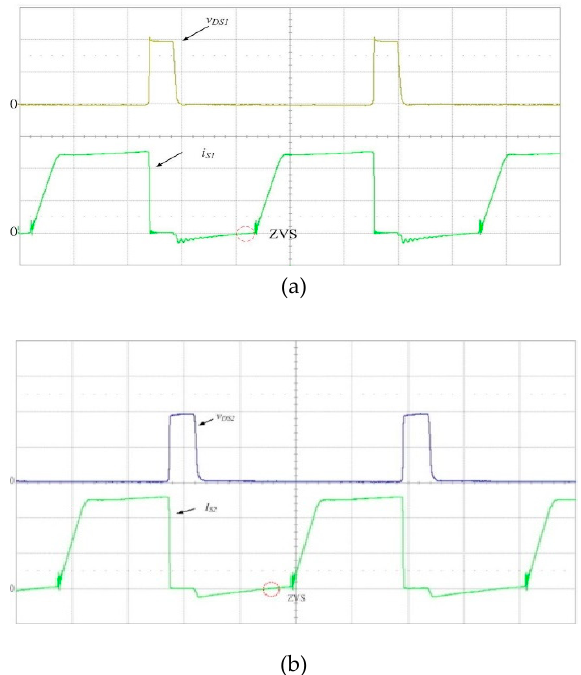
Figure 9. Voltage and current waveforms ( a ) v DS1 and i S1 , and (b ) v DS2 and i S2 . ( v DS1 , v DS2 : 200 V/div, i S 1 , i S 2 : 2 A / div, time: 5 µ s /